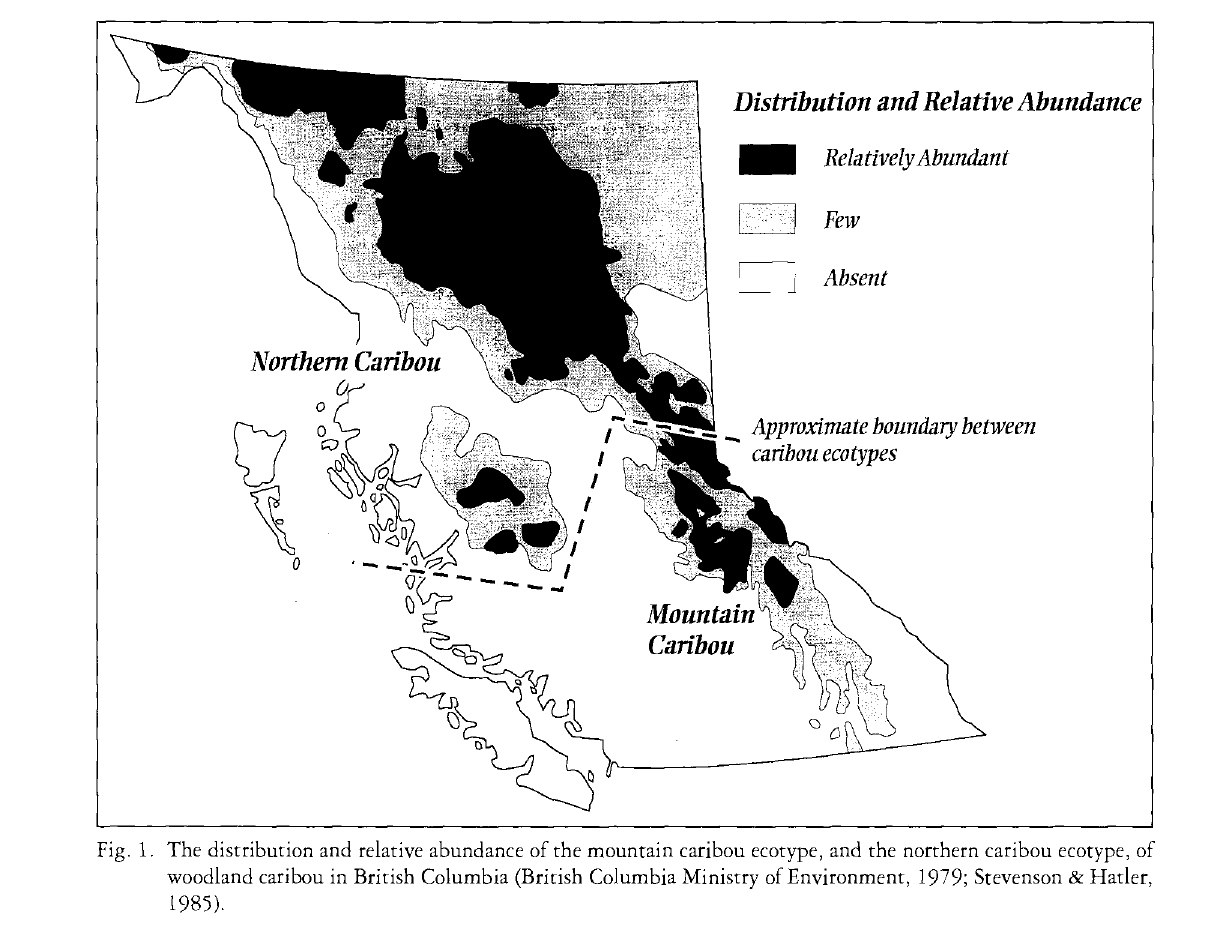
Fig. 1. The distribution and relative abundance of the mountain caribou ecotype, and the northern caribou ecotype, of woodland caribou in British Columbia (British Columbia Ministry of Environment, 1979; Stevenson & Hatler,